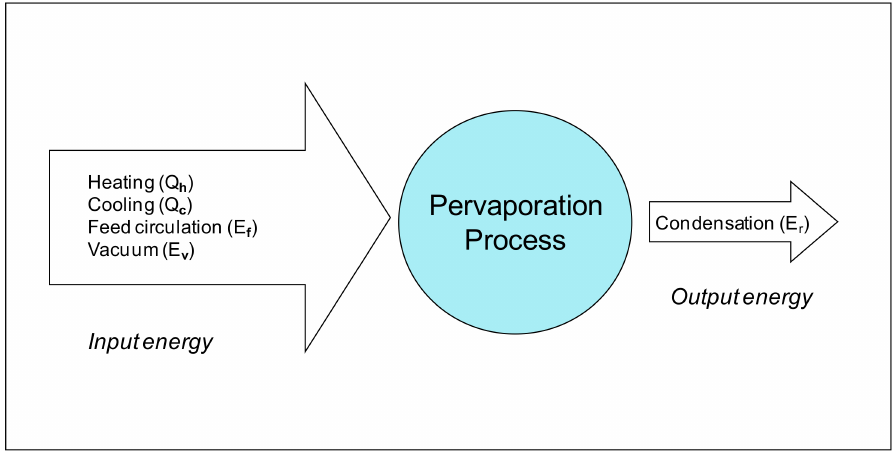
Figure 2. Breakdown of energy required for